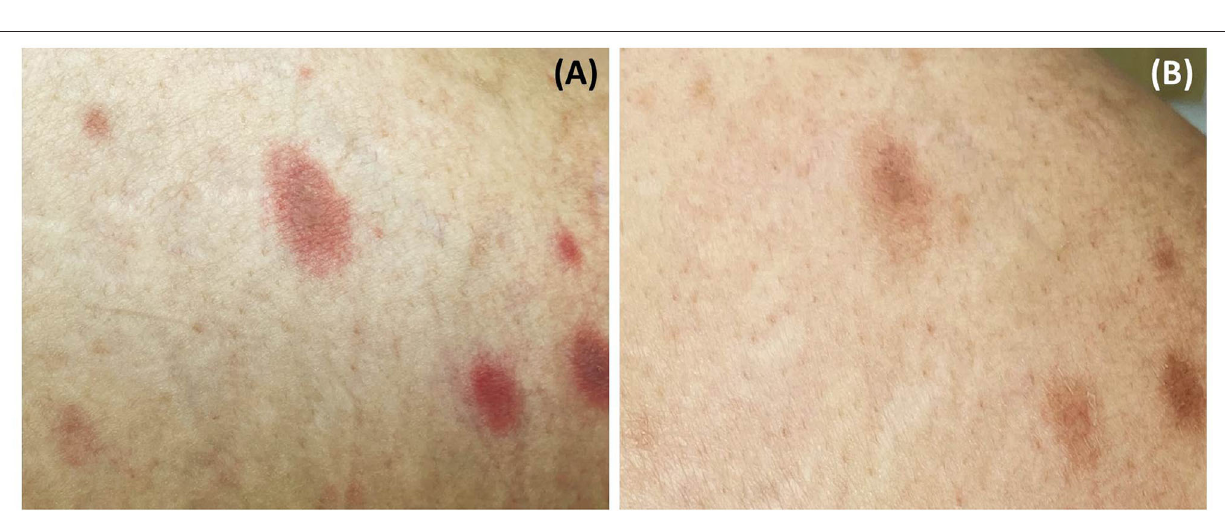
(Figure 2A) . Few brownish patches also appeared, suggestive of post-inflammatory hyperpigmentation. Unfortunately, due to her deteriorating neurologic status, her associated symptoms